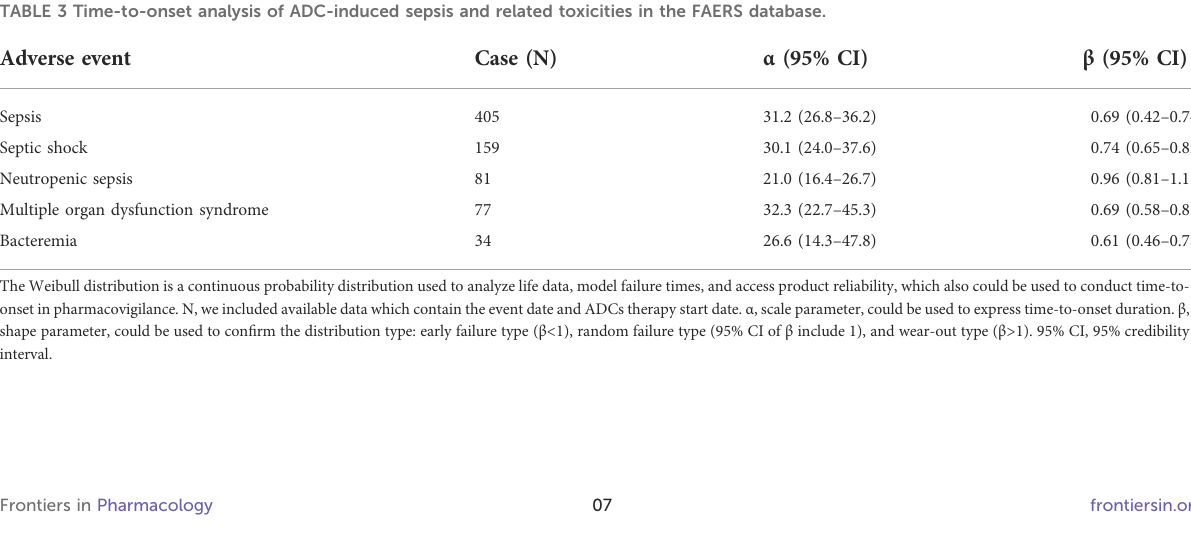
ADC and PPI combination therapy (Table 6). Safety concerns for combination of ADCs and H2-receptor antagonists (Table 7). We then included the most common CYP3A4/5 strong inhibitors which contain protease inhibitors, imidazole and triazole derivatives, and macrolides, and analyzed sepsis-related toxicities when ADCs were combined with the previously listed CYP3A4/5 inhibitors. We for the combination than for ADC monotherapy (Table 8).